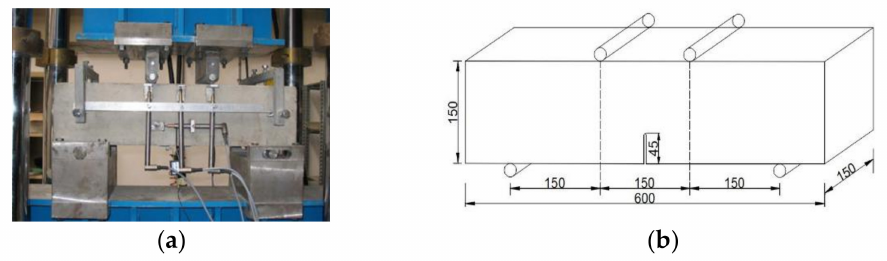
Figure 3. Four-point bending test: ( a ) Example of the test setup; ( b ) specimen